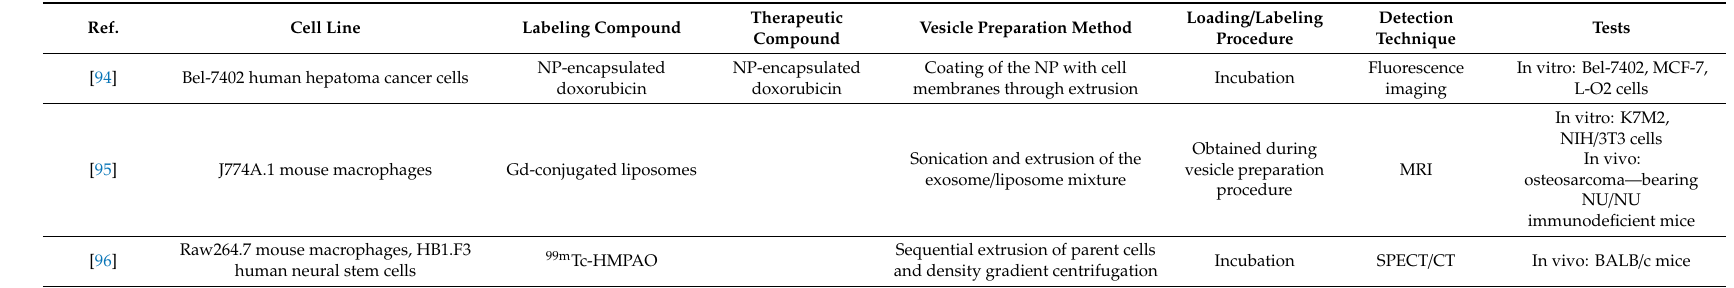
Table 2. Theranostic platforms based on exosome-mimetic